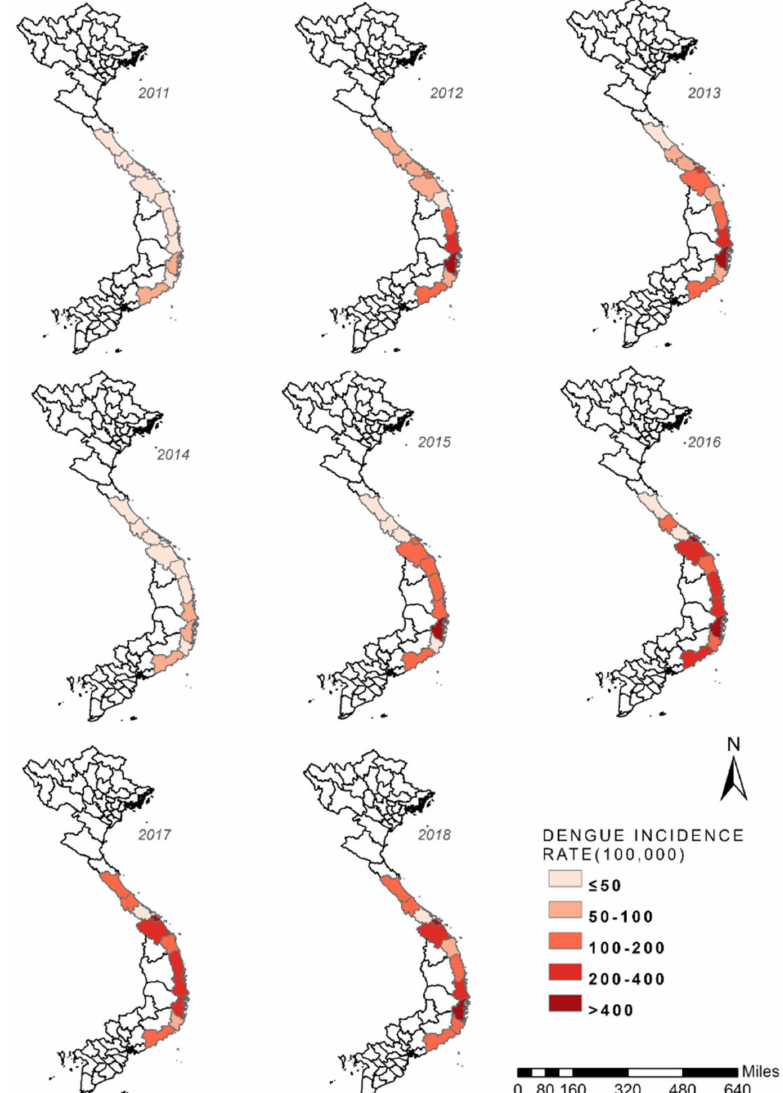
Figure 3. Spatial and temporal patterns in the incidence of dengue in central Vietnam between 2011 and